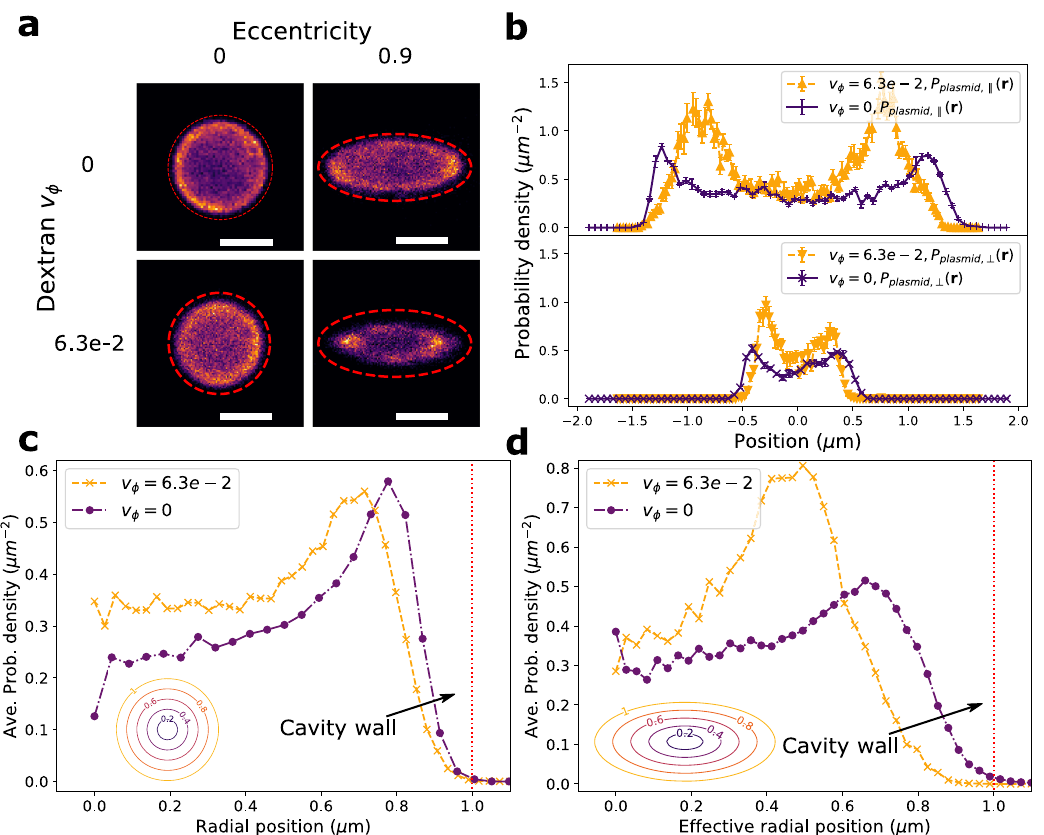
Fig. 8 Experimental results for a cavity con fi ned plasmid in presence of T 4 -DNA with added macro crowders. a Plasmid probability density in cavity, obtained from histogrammed plasmid position measurements, with and without crowding and for a symmetric and anisotropic cavity. The crowder volume fraction is v ϕ = 6.3 ⋅ 10 − 2 and the scale bars are 1 μ m. The red dashed line gives the cavity edge. b Cross-section of the plasmid position probability along the cavity major axis (upper panel) and along the cavity minor axis (lower panel). The length of the semi-major axis of the cavity is 1.51 μ m. The length of the semi-minor axis of the cavity is 0.66 μ m. The error bars denote the standard error of the mean of the binned probability density ( n = 3 bins). c Radially averaged plasmid probability density. The inset shows the contour along which the probability density average is taken. d Plasmid probability density ¼ , where a and b correspond to the length of semi-major and semi-minor averaged over an elliptical contour versus effective radial coordinate r eff axis respectively. The inset shows the elliptical contours along which the probability density average is